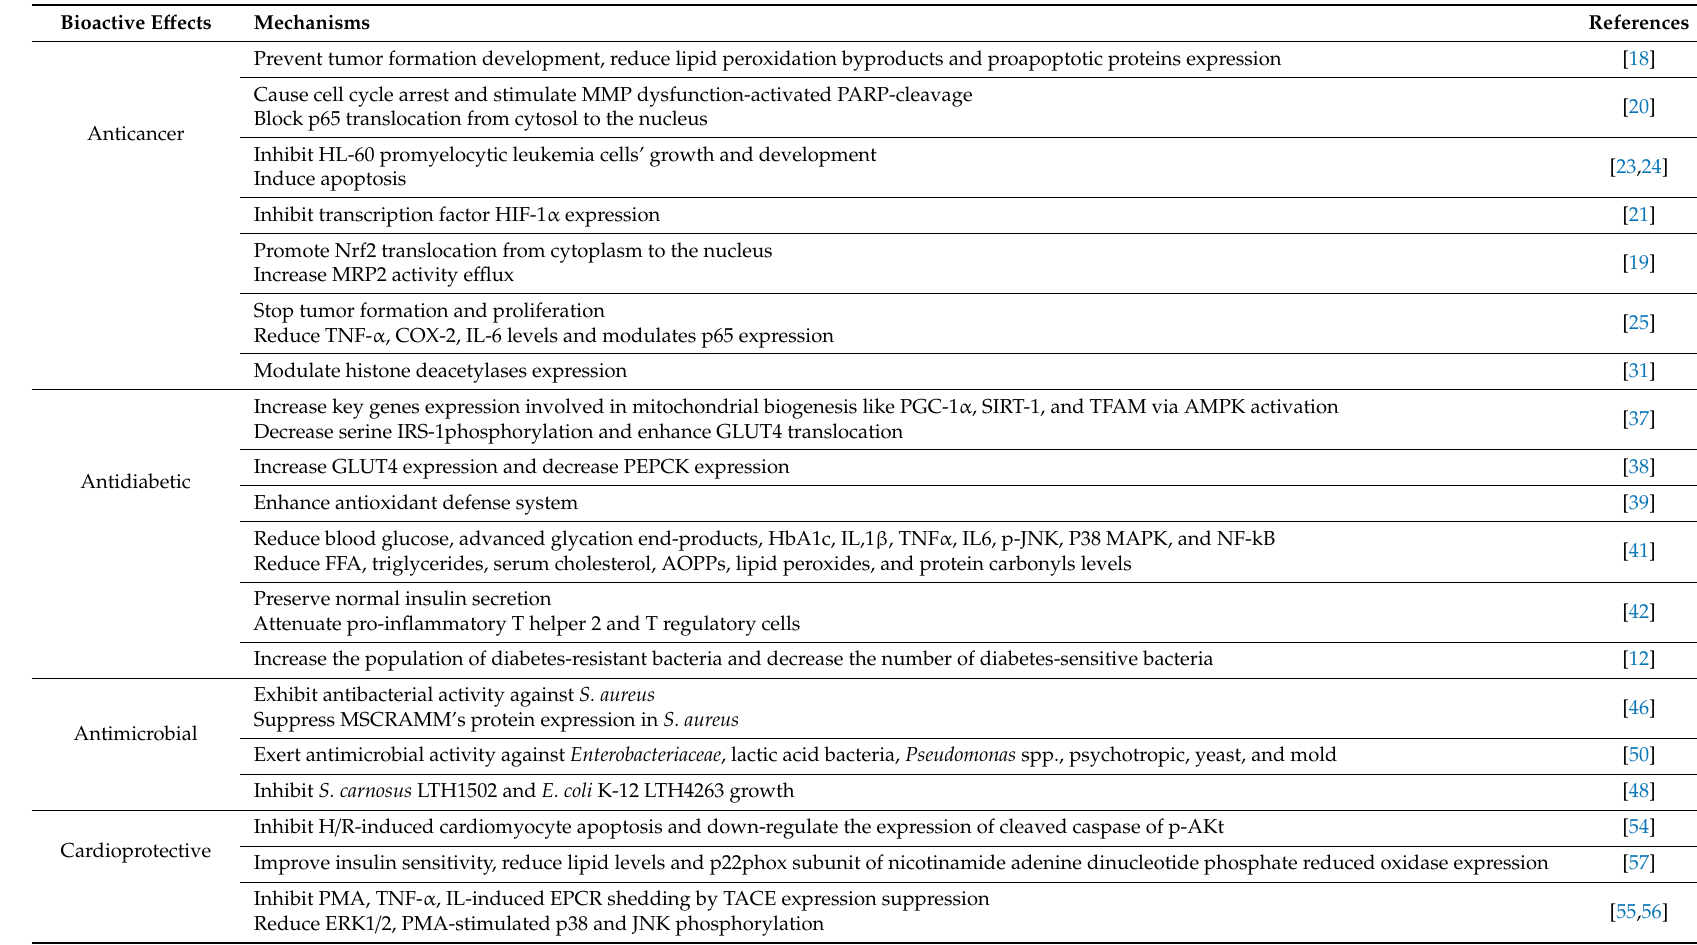
Table 1. Bioactive e ff ects of rosmarinic